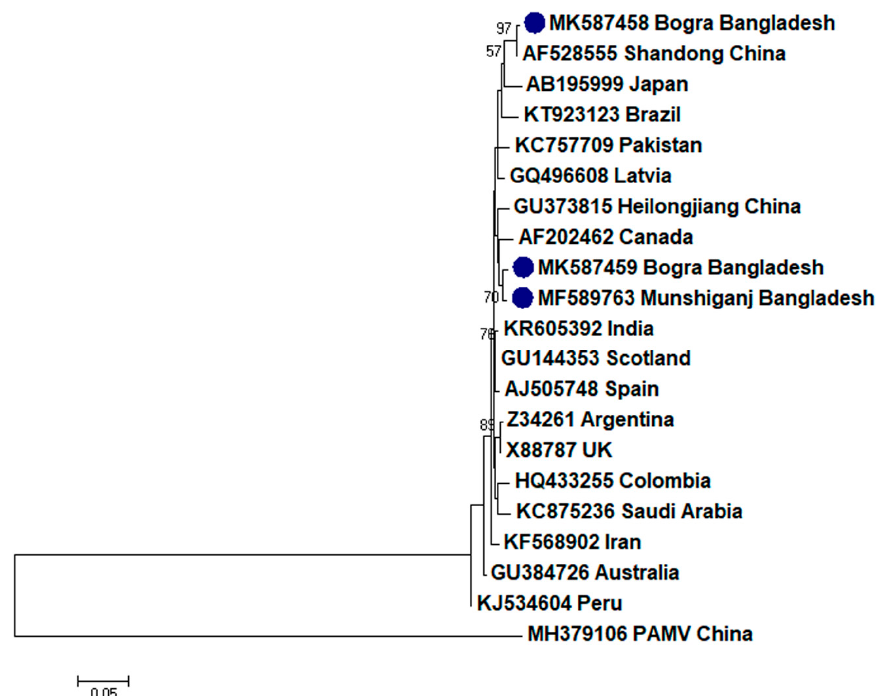
Figure 2. Phylogenetic analysis of Potato virus X detected from Bangladesh based on the coat protein gene sequences (nt) of different selected isolates from the NCBI database. The phylogenetic tree was generated by MEGA7 using neighbor-joining method with 1000 bootstrap replicates, and only values >50% are shown at the nodes. An isolate of Potato aucuba mosaic virus (PAMV) from China was used as an outgroup.